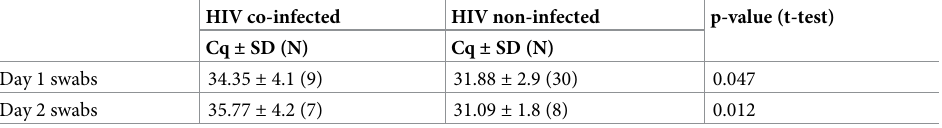
Table 4. Association between OSA signal strength and HIV co-infection among patients with positive tongue